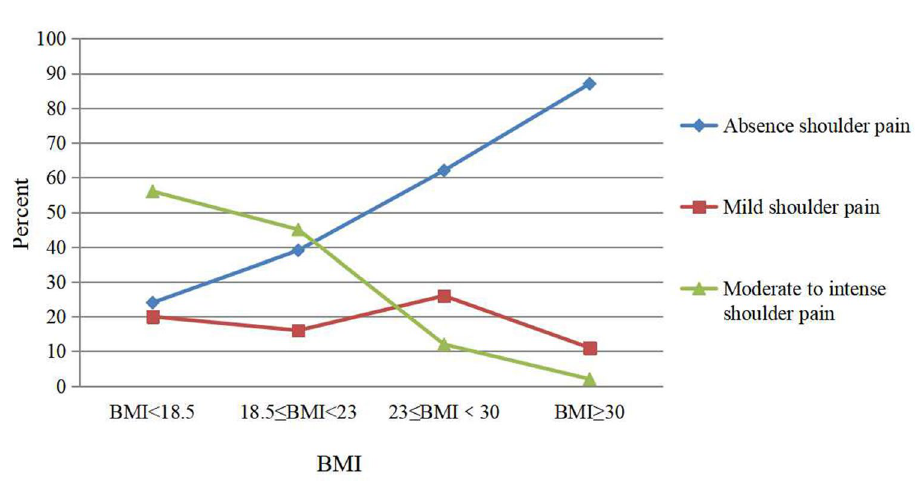
Figure 3. The relationship between PLSP and BMI. The patients were grouped according to the Asian BMI standard. The proportion of patients with different degrees of shoulder pain in each group is